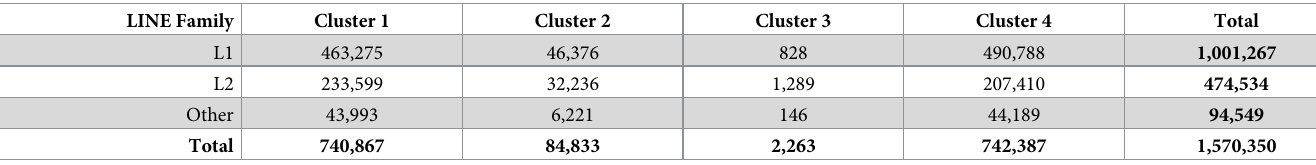
Table 6. Clustering of LINE